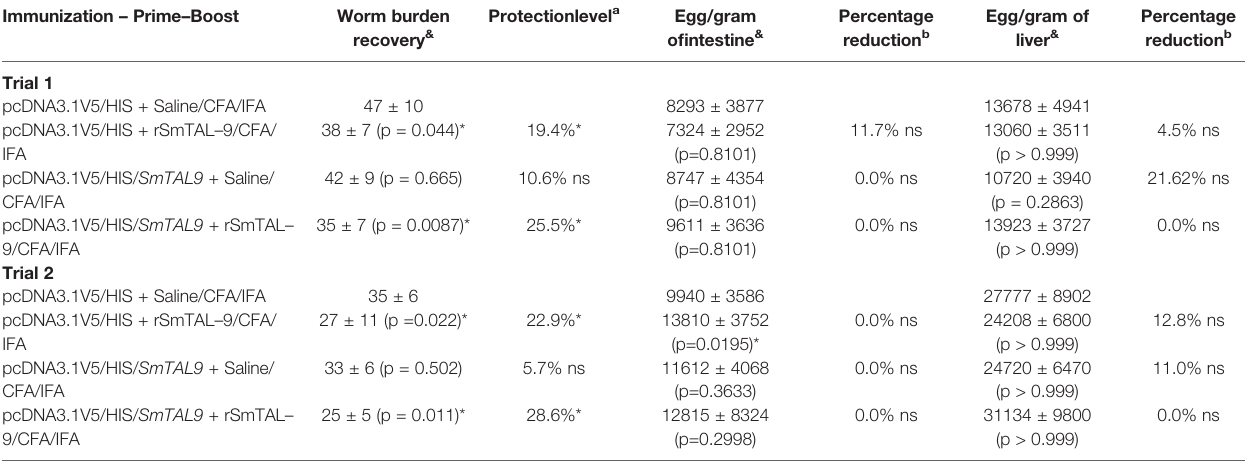
TABLE 3 | Protection induced by a prime (DNA vaccination) – boost (recombinant protein) regimen using SmTAL – 9 as the antigen. Immunization – Prime – Boost